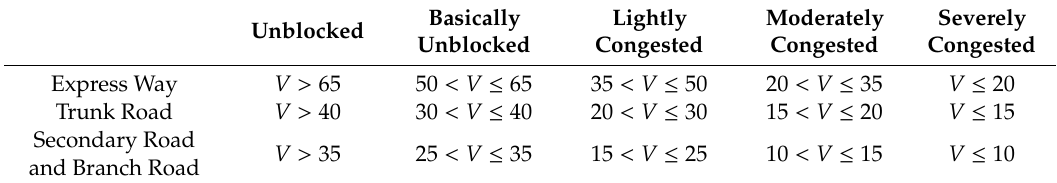
Table 2. Classification of the road section tra ffi c